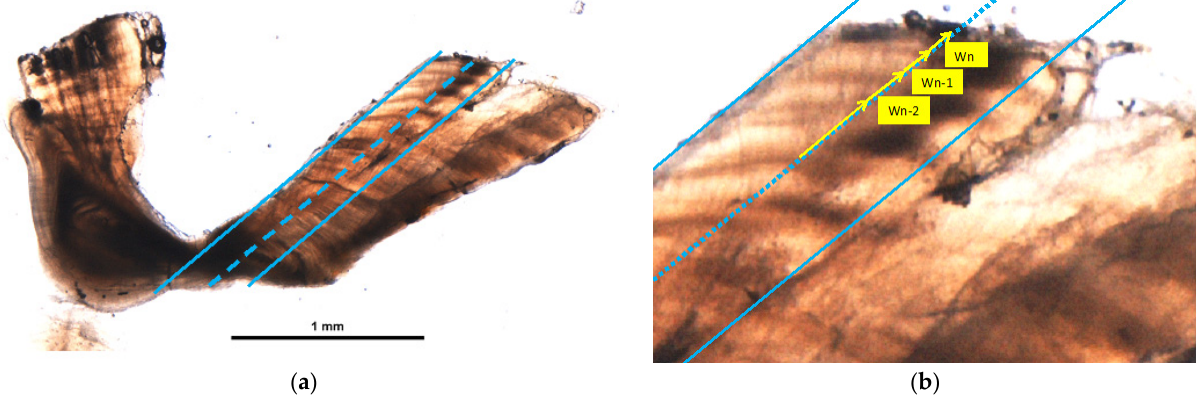
Figure 1. Bluefin tuna otolith showing measurement lines ( a ) and Wn, Wn-1, and Wn-2 measurements identified with yellow arrows; ( b ) is a 7-year-old individual with a narrow translucent marginal